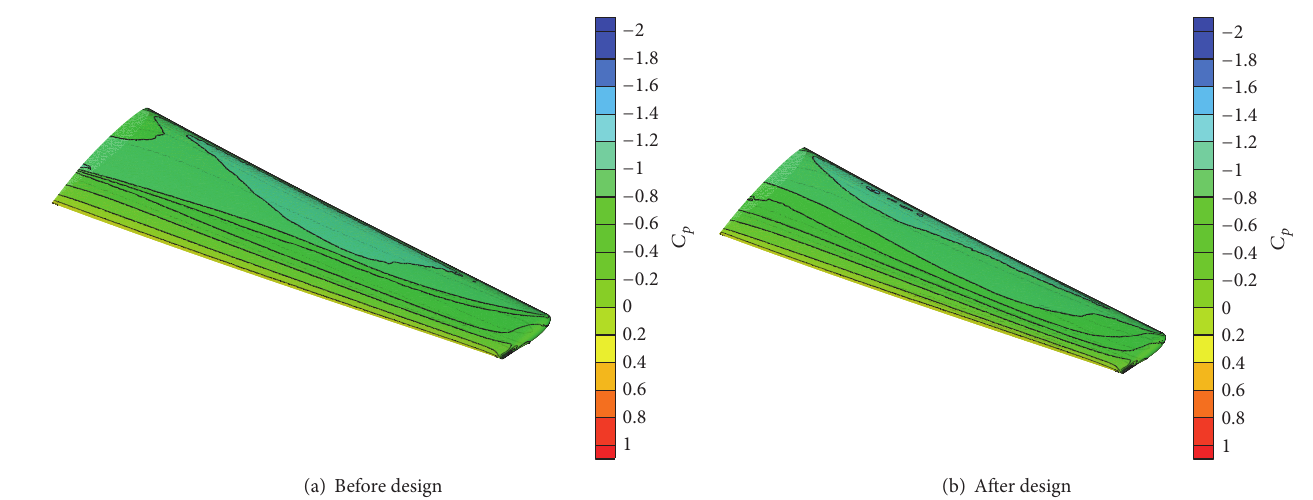
Figure 14: Contours of pressure coefficient of flexible wing.